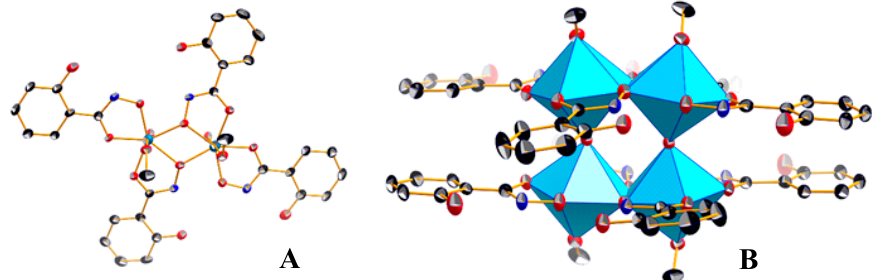
Figure 2. Ball-and-stick plot of the structural unit [Ti IV2 (HOCH 3 ) 2 ( μ - η 1 , η 2 -Hdihybe- O , O ′ ) 2 ( η 1 , η 1 -Hdihybe- O , O ′ ) 2 ] ( A ). Polyhedral/ball-and-stick representation of the cation of 1 ( B ).